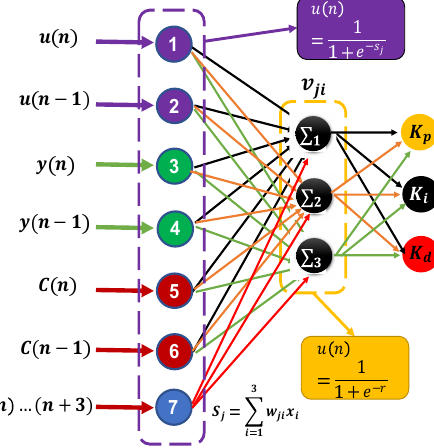
Figure 6. Block diagram of the implemented